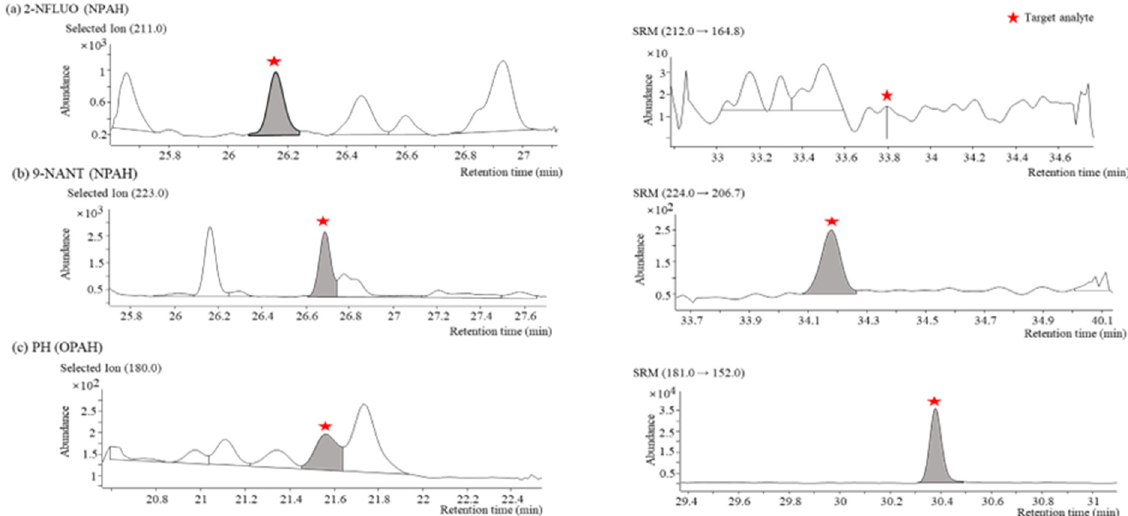
Figure 4. Comparison of separation characteristics of target PAH derivatives in actual aerosol sam- ples obtained by GC-NCI/MS ( left ) and GC-PCI-MS/MS ( right ): ( a ) SIM ( m/z = 211) and SRM ( m/z 212 → 164.8) chromatograms of 2 − NFLUO (NPAH); ( b ) SIM ( m/z = 223) and SRM ( m/z 224 → 206.7) chromatograms of 9 − NANT (NPAH); ( c ) SIM ( m/z = 180) and SRM ( m/z 181 → 152) chromatograms of PH (OPAH).